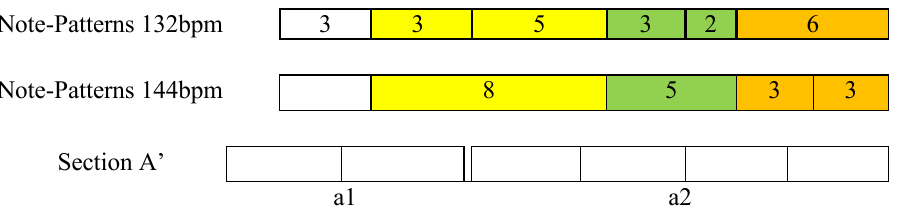
Figure 13. Example of the amalgamation of note-patterns from one version (132bpm) to another (144bpm), Player #2, beginning of the A’ section (segments a1 and a2) of the musical excerpt of ‘Porgy and Bess’.